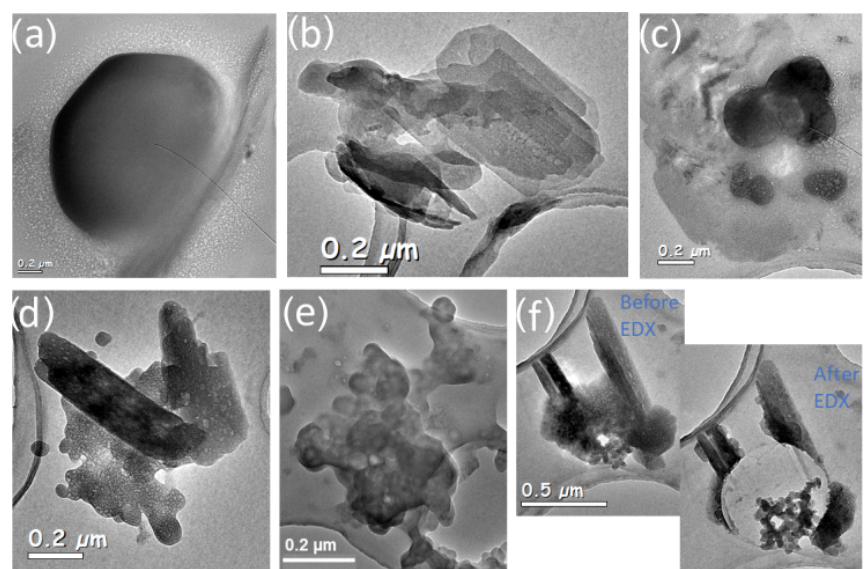
Figure 6. Assorted sea salt particles. (a) ∼ 1 . 5µm rounded NaCl, Gold 1; (b) CaSO 4 , Gold 1; (c) NaCl and Mg, Gold 1; (d) Na 2 SO 4 with K, Gold 1; (e) NaNO 3 mixed with BC, Gold 24; and (f) BC encapsulated in Na 2 SO4 with K,